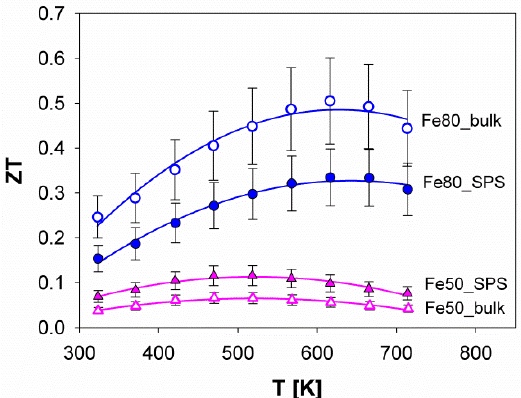
Figure 12. ( a ) The trend of ( 𝜆 𝑜𝑣 − 𝜆 𝑒𝑙 ) vs. 1/T for samples Fe80_SPS and Fe50_SPS. The dashed lines are a guide for the eye. The temperatures reported within the diagram roughly indicate the threshold above which the bipolar contribution starts growing steeply; ( b ) fit of ( 𝜆 𝑝ℎ + 𝜆 𝑏𝑝 ) data (continuous line) performed according to Equation 6) (dashed-dotted line) and to Umklapp scattering (dashed line).